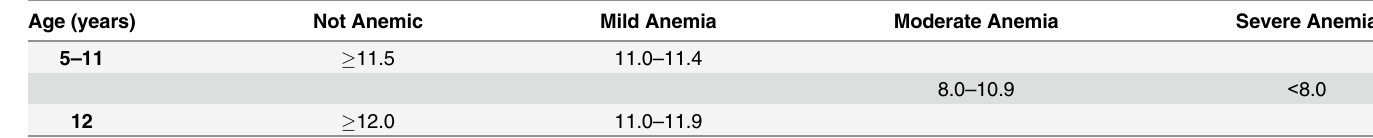
Table 1. Reference values for anemia diagnose